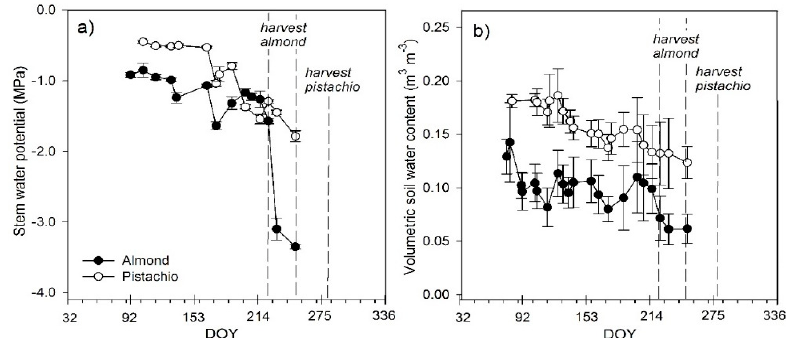
Figure 3. Seasonal trends of averaged ( a ) stem water potential ( Ψ stem ), and ( b ) volumetric soil water content ( θ v ) in the top 0.9 m of the soil profile in the three plots of the almond and pistachio. Dashed lines indicated harvest dates for almond (the two lines indicated the harvest for cvs. Nonpareil and Carmel ) and pistachios.